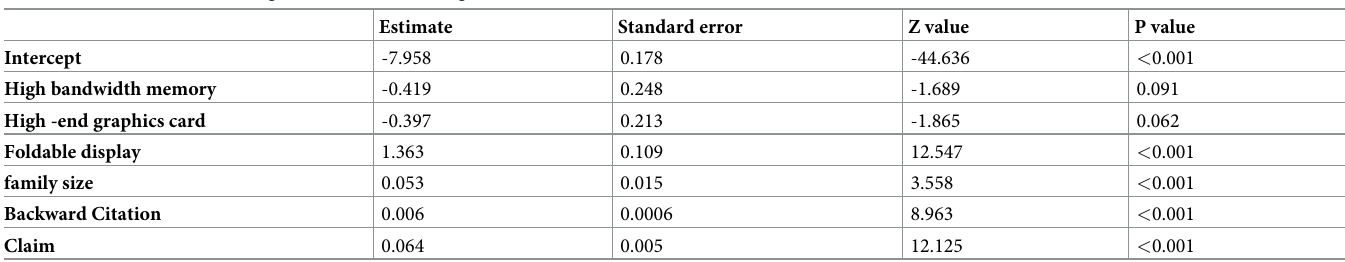
Table 3. Fitted count model (negative binomial with log link).